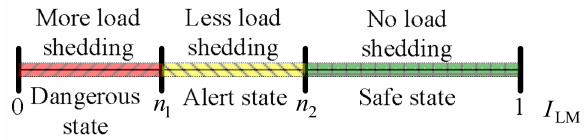
Figure 4. The load-shedding zoning control chart for the load margin index I LM